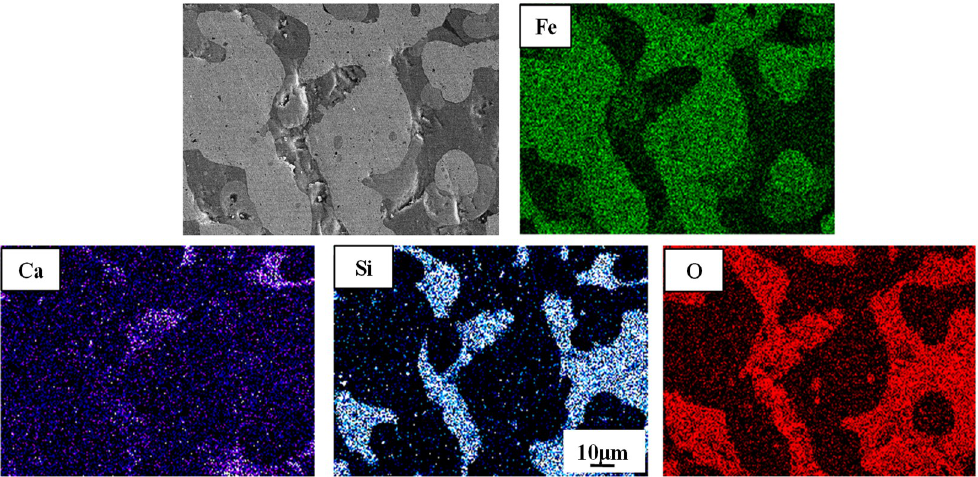
Figure 19. Element distributions of PB at T S .